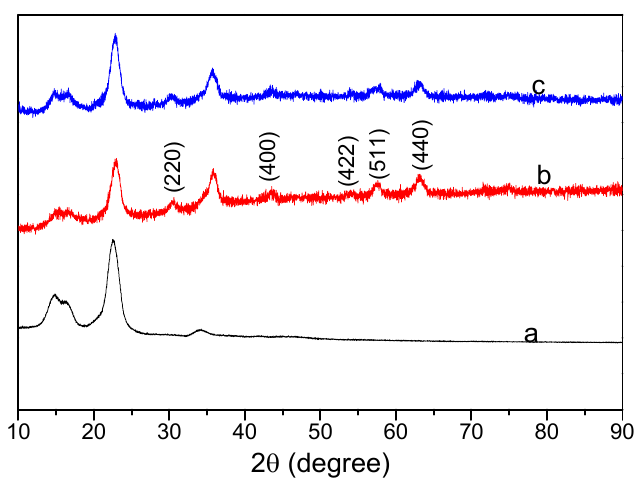
Figure 5. XRD patterns of ( a ) pristine cotton fabrics, ( b ) cotton@PVP@Fe 3 O 4 composites, and ( c ) FAS- modified cotton@PVP@Fe 3 O 4 composites.